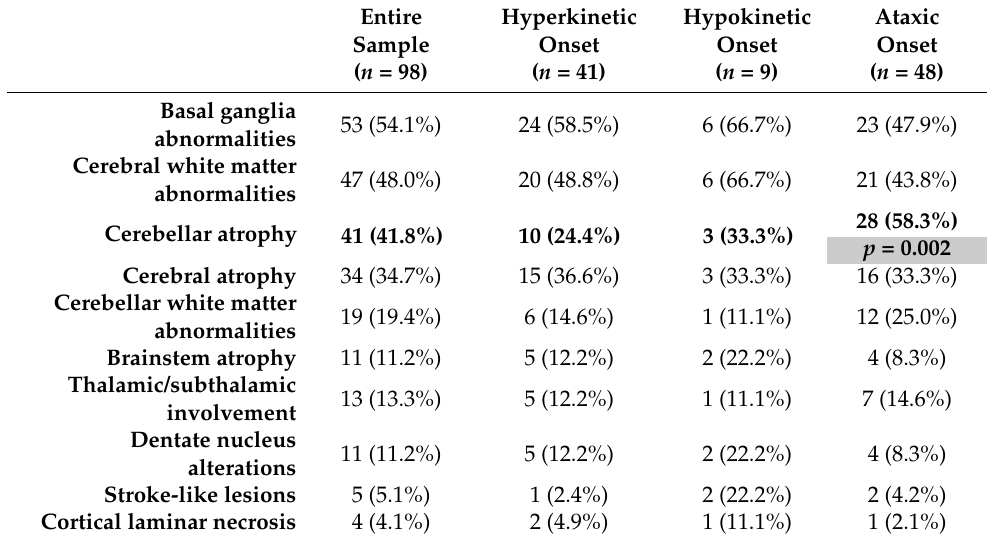
Table 2. MRI abnormalities seen in mitochondrial paediatric-onset patients with movement disorders. n = 98 (imaging data were not available for 4 patients). MRI was completely normal in 6 patients (6.1%), with no significant difference between the subgroups. The association between ataxic onset and cerebellar atrophy is the only significant association in this table, with a border-line significance (significance level after Bonferroni’s correction: